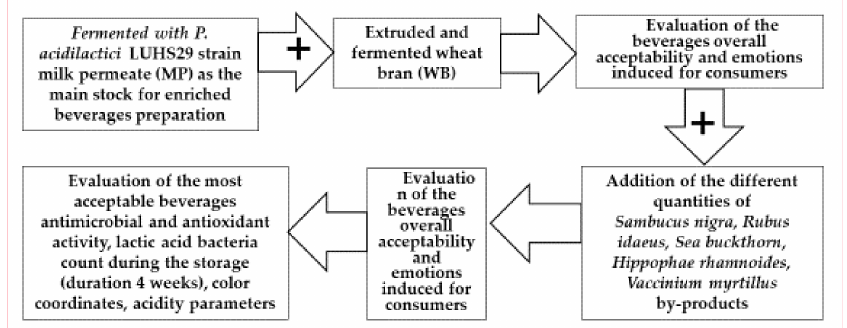
Figure 1. The experimental